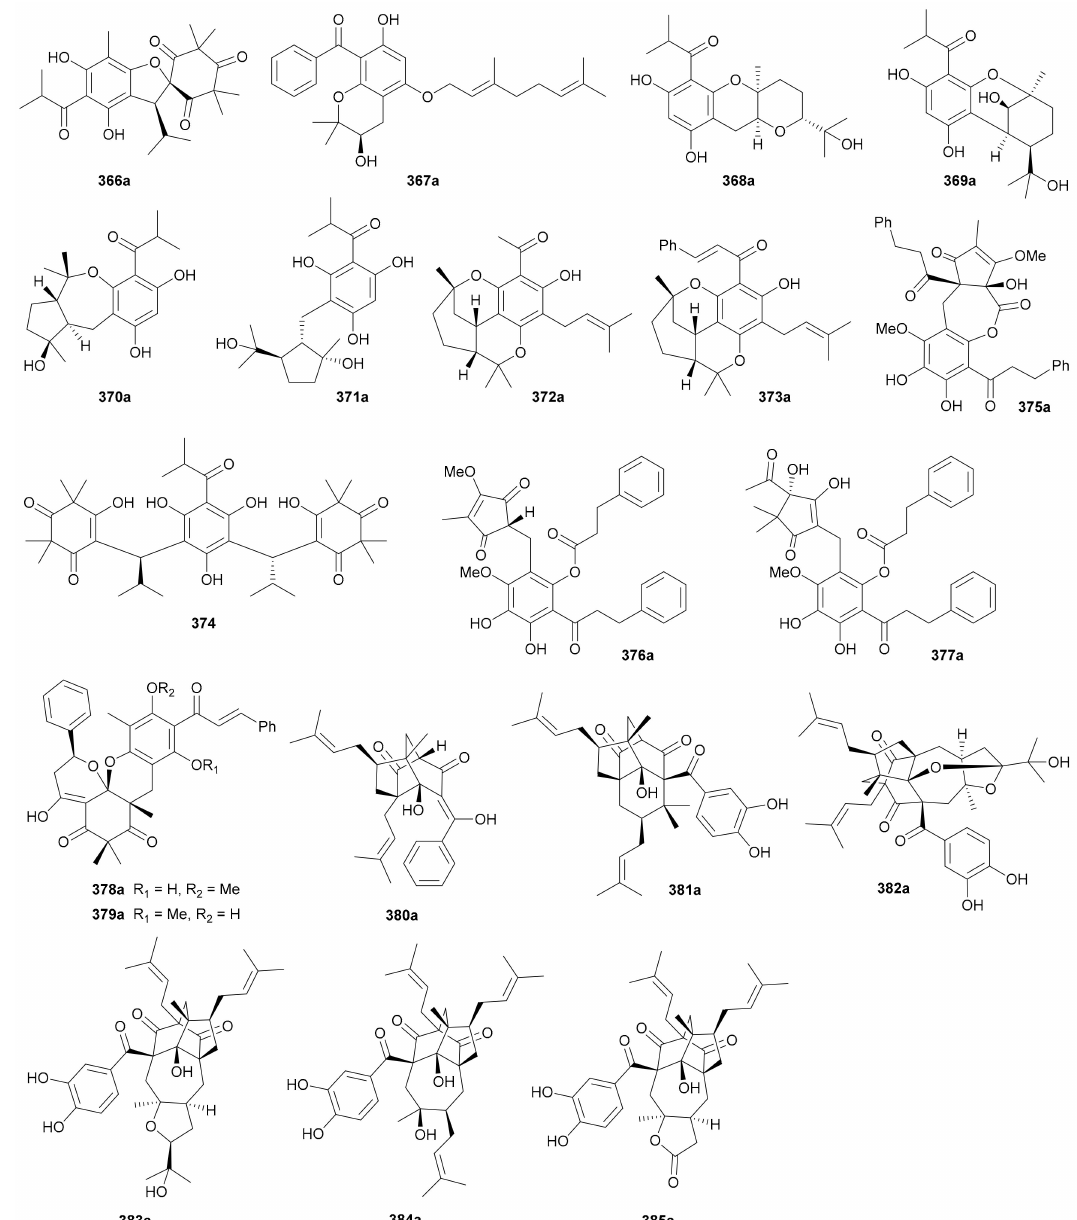
Figure 21. Structures of